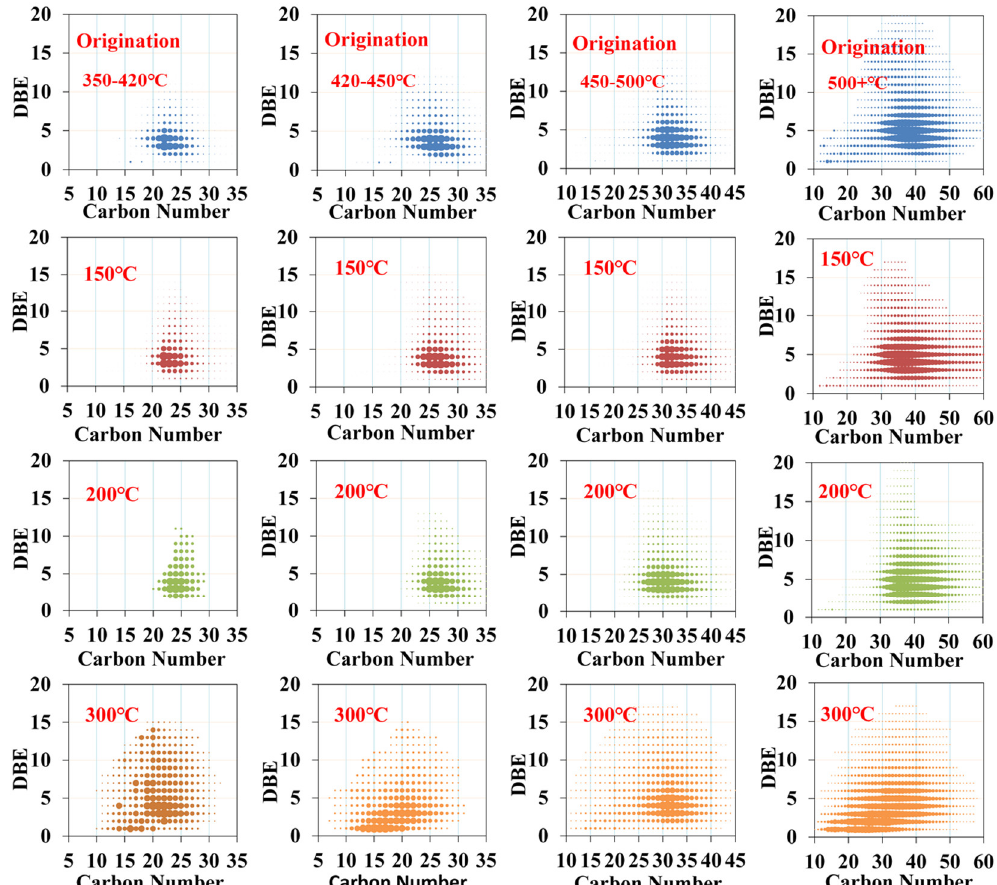
Figure 7. Carbon number and DBE diagram of O2 compounds.